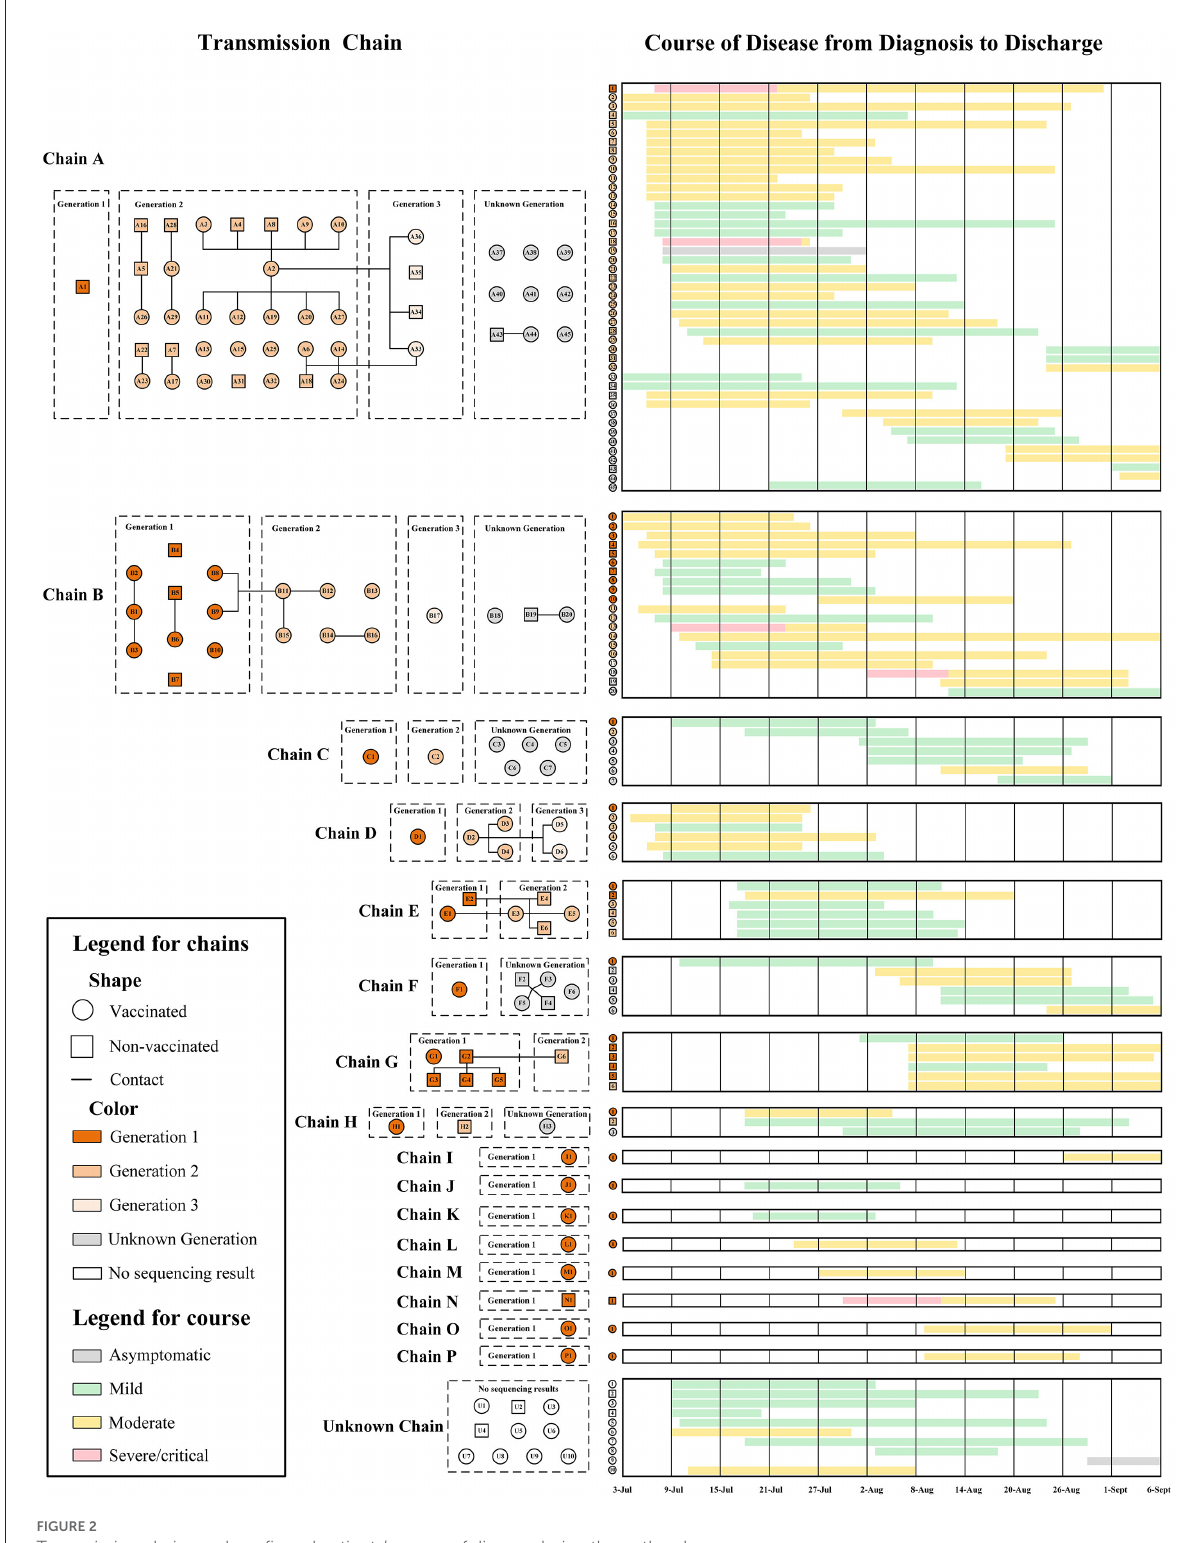
FIGURE2 Transmission chains and confirmed patients’ course of disease during the